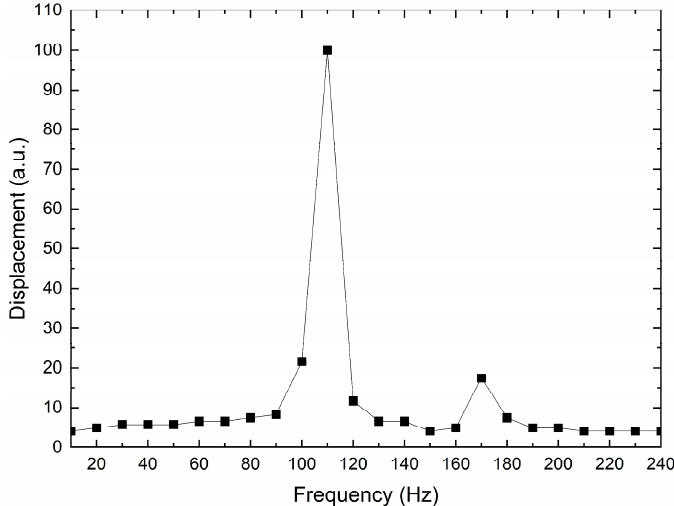
Figure 21. Graph of the frequency response of the piezoelectric-driven MG.